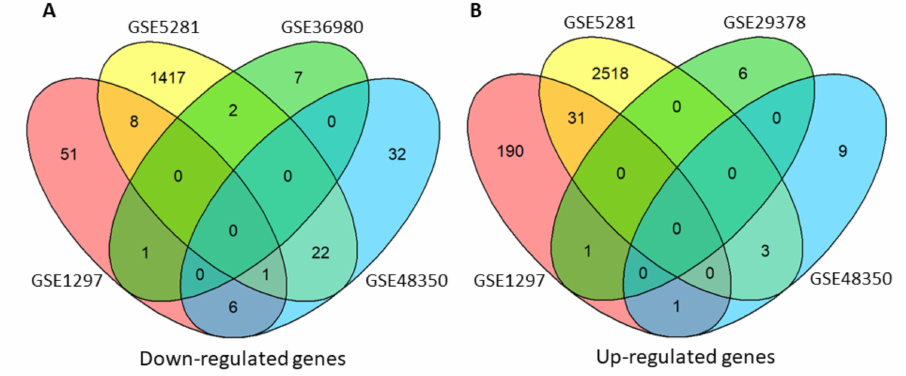
Figure 2. Venn diagram analysis of differentially expressed genes: ( A ) down-regulated genes; ( B ) up-regulated